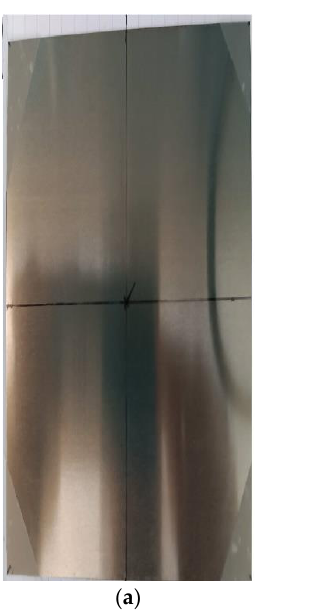
Figure 16. Image of the sample: ( a ) before the flaw; ( b ) with a flaw at its center.